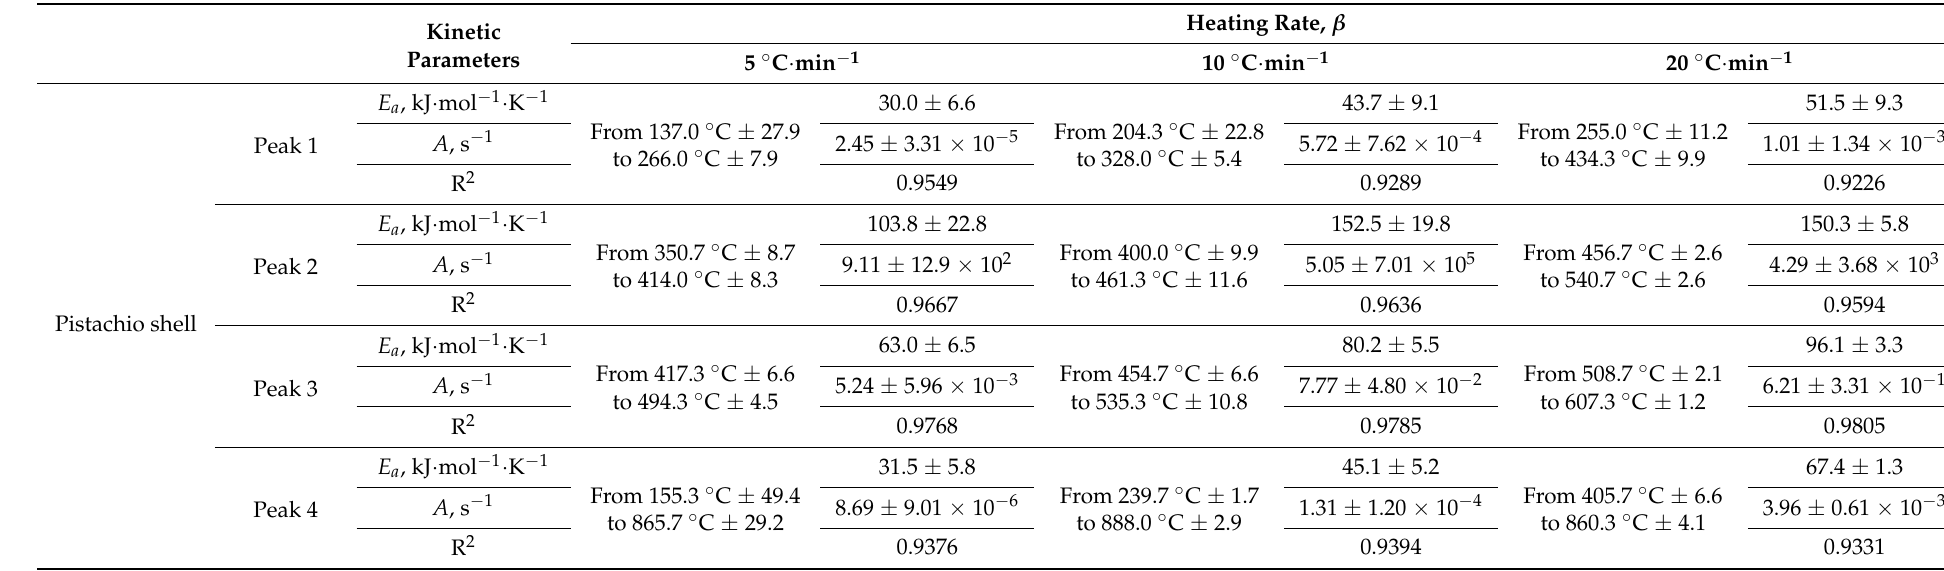
Table 8. Activation energy ( E a ) [kJ · (mol · K) − 1 ] and pre-exponential factor (A) [s − 1 ] for the PIS fitted